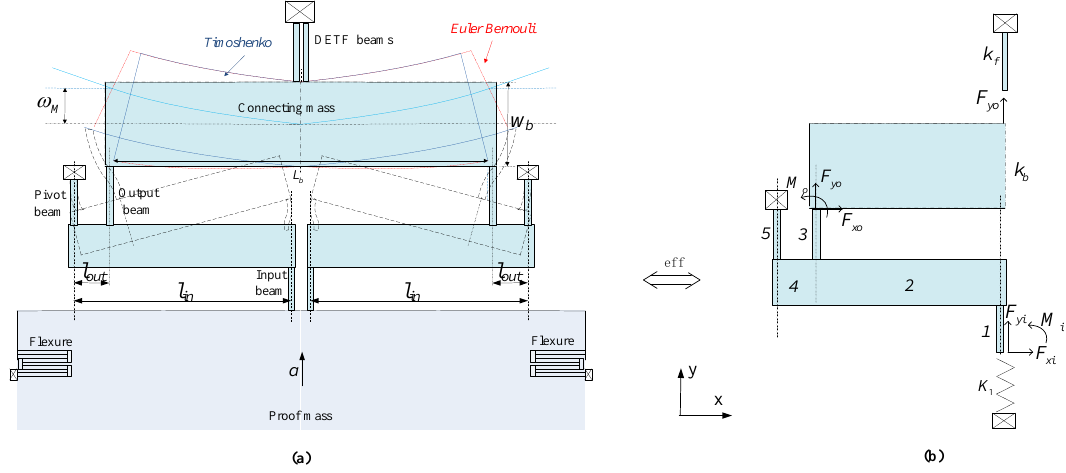
Figure 5. ( a ) Deformation of the micro-leverage mechanism; ( b ) The equivalent micro lever under loading